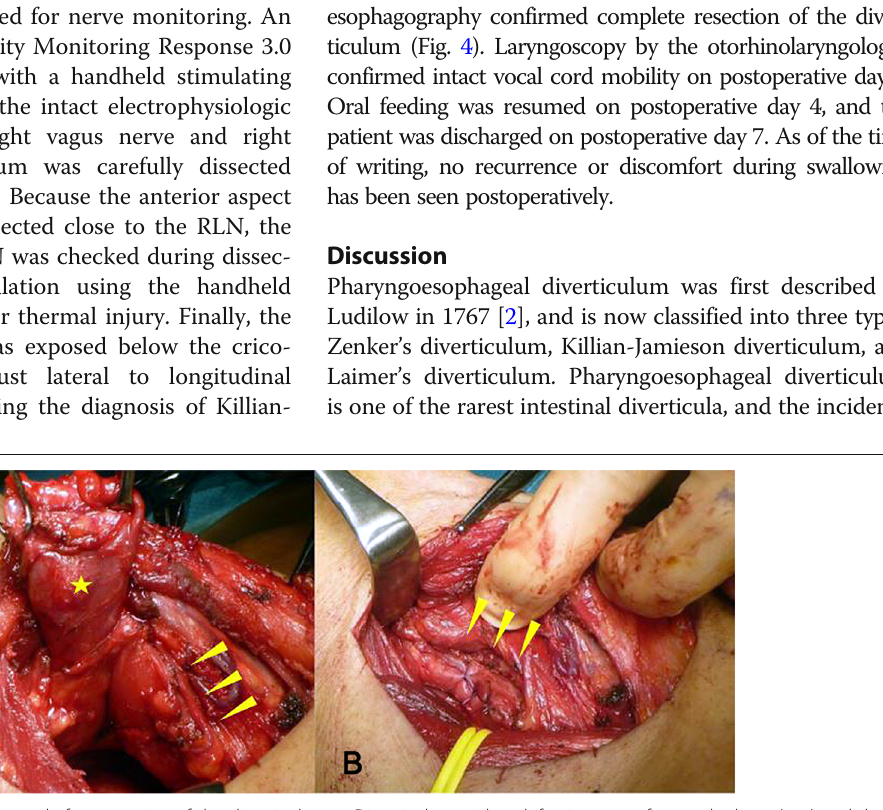
Fig. 2 Intraoperative pictures before and after resection of the diverticulum. a Diverticulum with a defective area of muscular layer (star) and the area of the right recurrent laryngeal nerve (arrowheads). b Area of the right inferior laryngeal nerve (arrowheads) and nearby sutured longitudinal